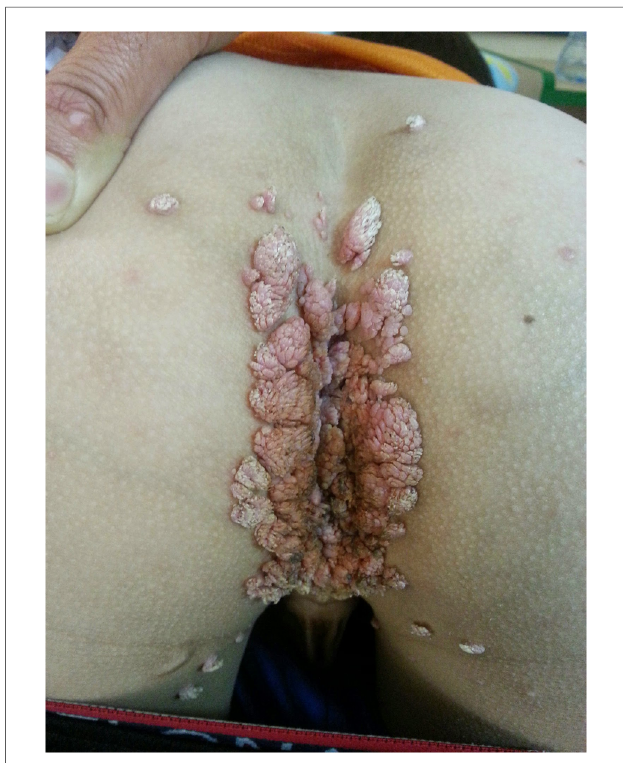
FIGURE 6 Diffuse widespread pink-gray verrucous exophytic papules and plaques on the perianal and perigenital regions of a 14-year-old boy with X-linked SCID, consistent with condyloma acuminata. SCID, severe combined immunode fi